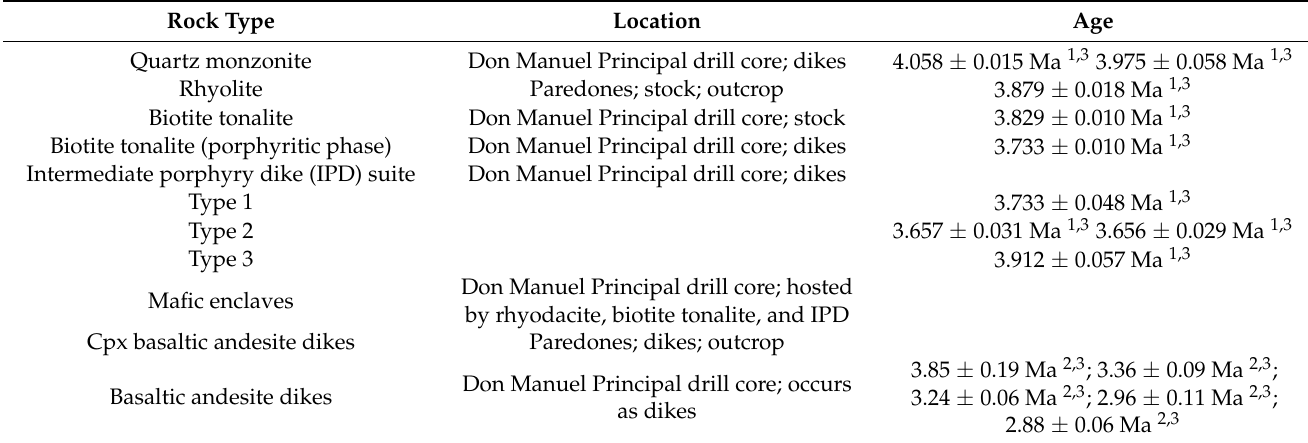
Table 1. Summary of the geochronology of the Don Manuel igneous complex,